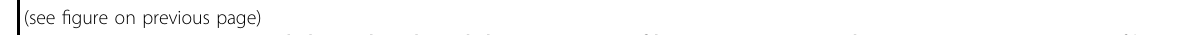
Fig. 1 Cryo-EM structures and electrophysiological characterizations of human TMEM120A and TMEM120B. a Cryo-EM maps of human TMEM120A and TMEM120B shown in two perpendicular views. Densities for the detergent micelle were omitted for visual clarity. The maps were contoured at level 0.7 and 0.6 for TMEM120A and TMEM120B in ChimeraX 9 , respectively. The dimer interfaces that are highlighted in the boxes are illustrated in detail in d with corresponding color borders. b TMEM120A and TMEM120B share nearly identical overall structure. TMEM120A and TMEM120B are colored cyan and yellow, respectively. c Structural topology of TMEM120A. One protomer is colored gray and the other is colored rainbow with the N- and C-terminus in blue and red, respectively. TMD, transmembrane domain; CCD, coiled coil domain. d Close-up views of the dimeric interfaces of TMD (left) and CCD (right). The TMD interfaces are along the C2 symmetry axis, which is indicated by the gray dashed lines. The C2 symmetry axis in the CCD is indicated by the circle in the upper panel. e Representative traces of poking-evoked whole-cell currents from HEK293T-P1KO cells transfected with mPiezo1 and TMEM120A, or from HEK293T cells transfected with TMEM120B and vector. f Statistic plot of the poking-evoked currents along the increase of indentation depth. g Representative traces of stretch-induced currents in a cell-attached mode from HEK293T-P1KO cells transfected with hPiezo1, TMEM120A, and vector. The stretch durations are indicated by red bars. h Statistic plot of the stretch- induced currents along the increase of negative pressure. i Structural comparison between TMEM120A and ELOVL7 elongase (PDB: 6Y7F), shown as cylindrical helices in two perpendicular views. The 3-keto acyl-CoA bound in ELOVL7 is shown as sticks. j Close-up view of the superimposition near the HxxHH motif in the catalytic site of ELOVL7. k A stretch of electron density is identi fi ed in the intracellular pocket of TMEM120A, which is surrounded by positively charged residues. The density is contoured at 4 σ . Structure fi gures were prepared in PyMOL 10